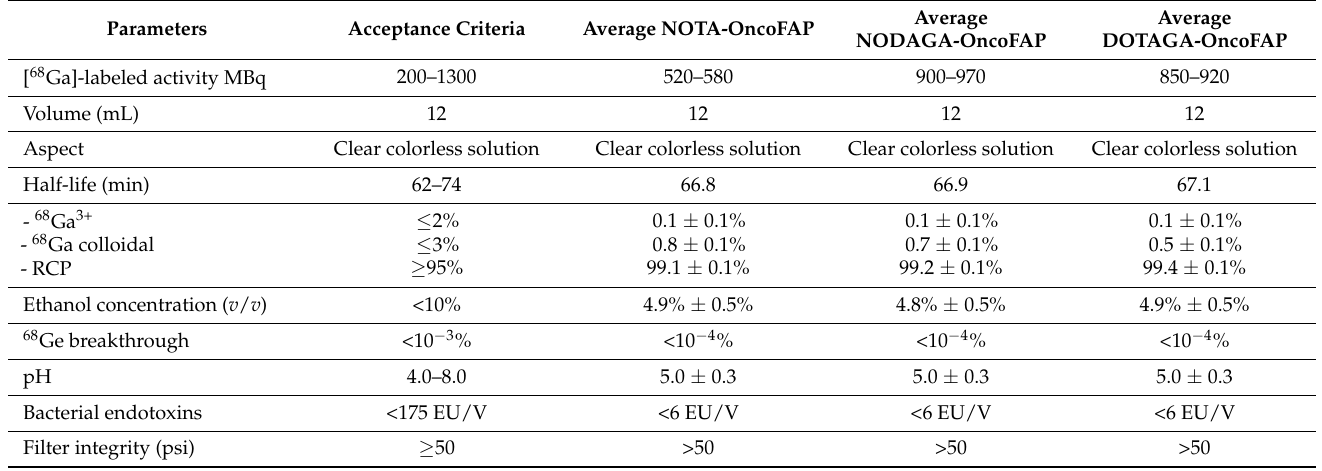
Table 4. Acceptance criteria and average result of five [ 68 Ga]-derivatives synthesis obtained with condition of condition